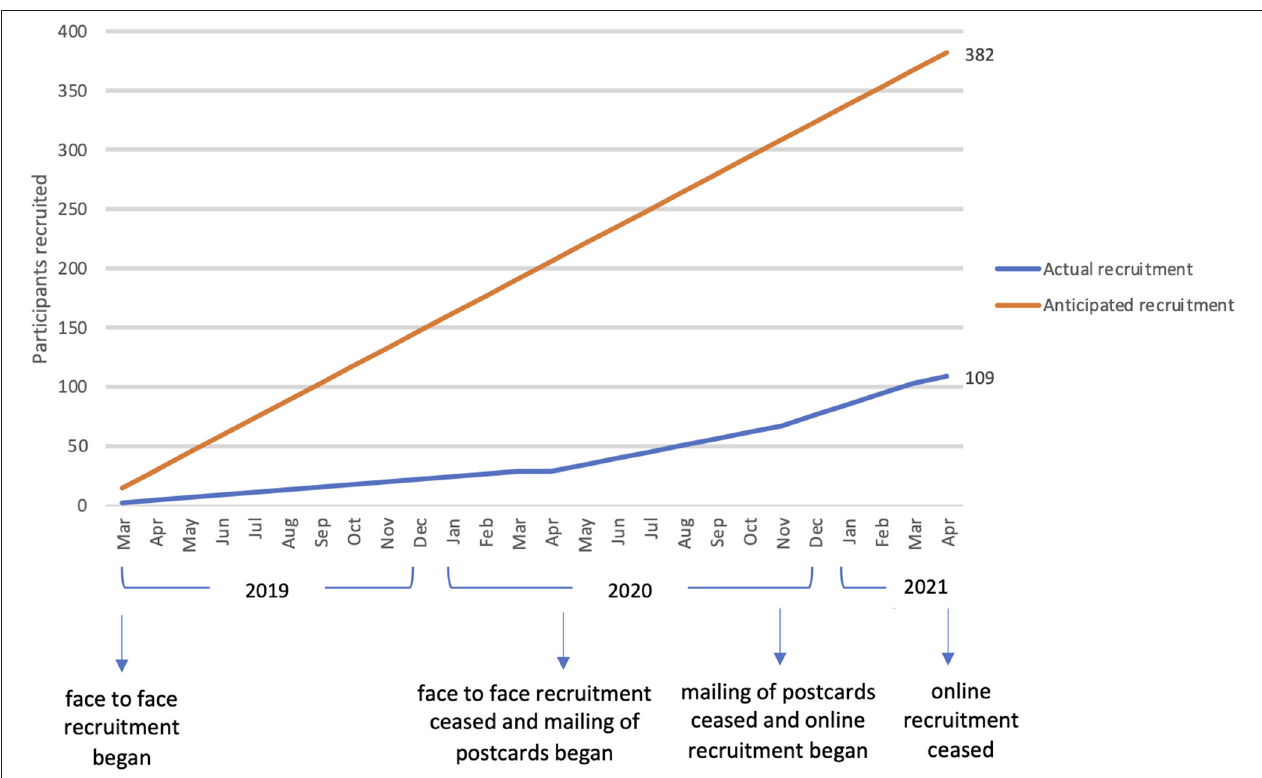
FIGURE 2 | Recruitment per month according to recruitment